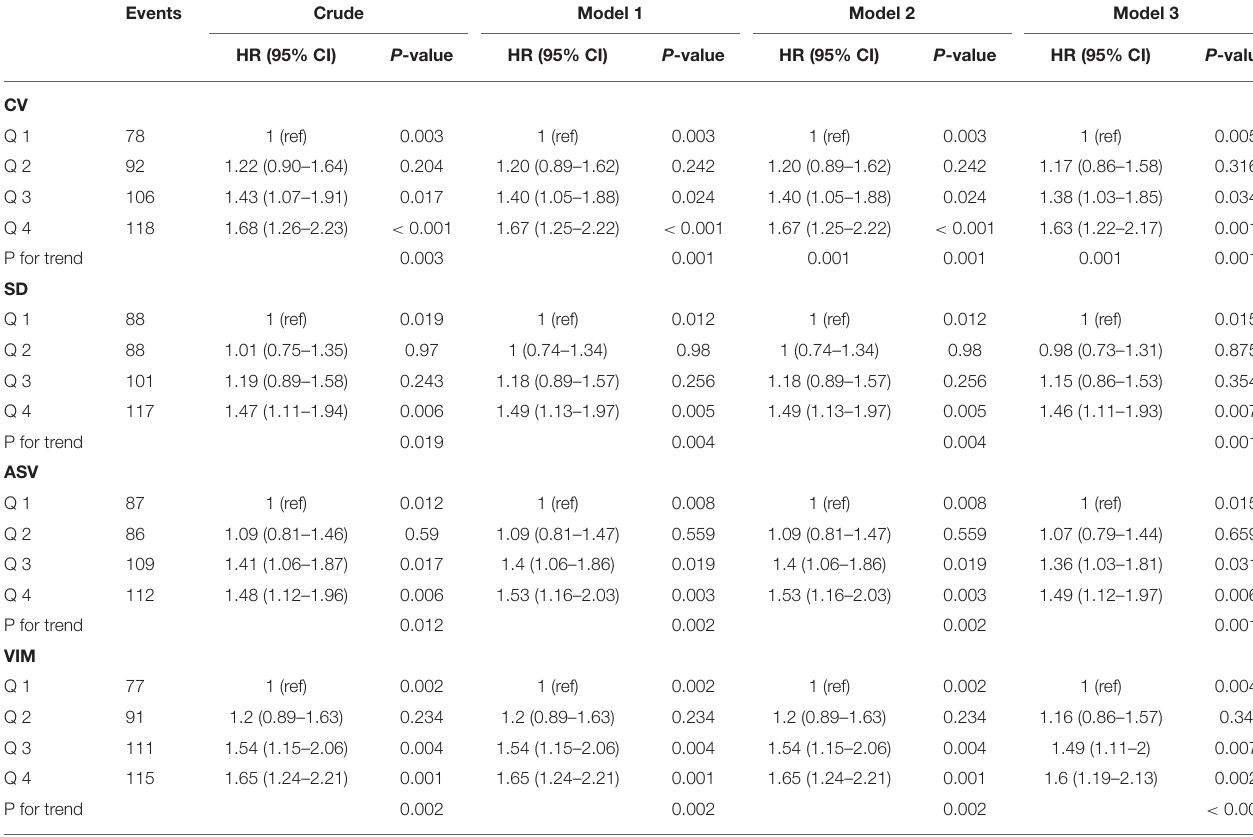
TABLE 2 | Hazard ratios and 95% confidence intervals of MACCE by quartiles of total cholesterol variability. Events Crude Model 1 Model 2 Model 3